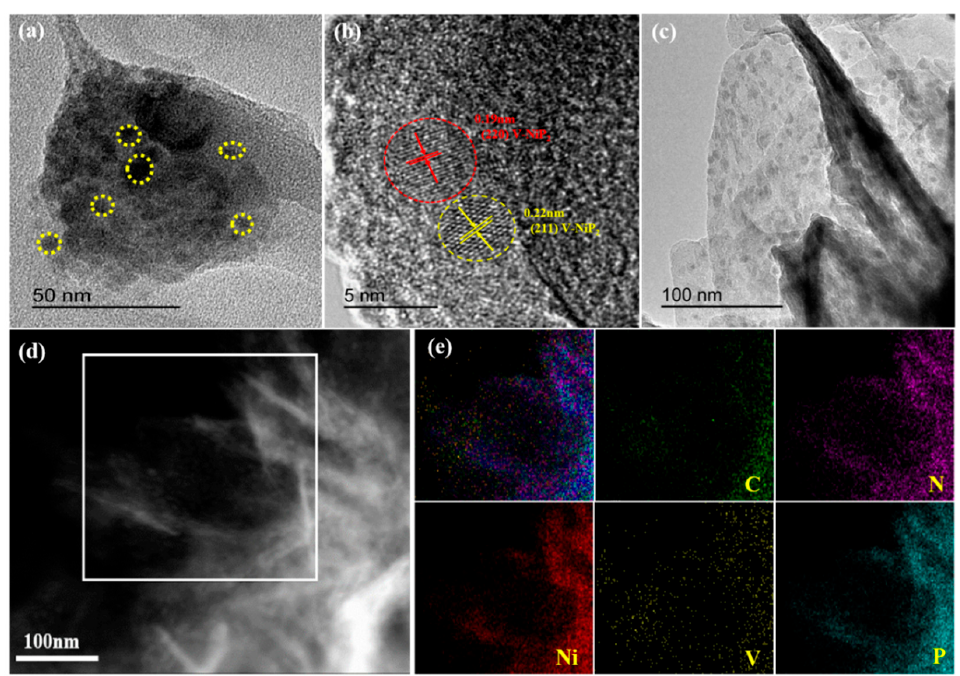
Figure 2. ( a , c ) TEM of V-NiP 2 /g-C 3 N 4 , ( b ) HRTEM of V-NiP 2 /g-C 3 N 4 ; ( d , e ) elemental mapping of C, N, Ni, V, and P, respectively.